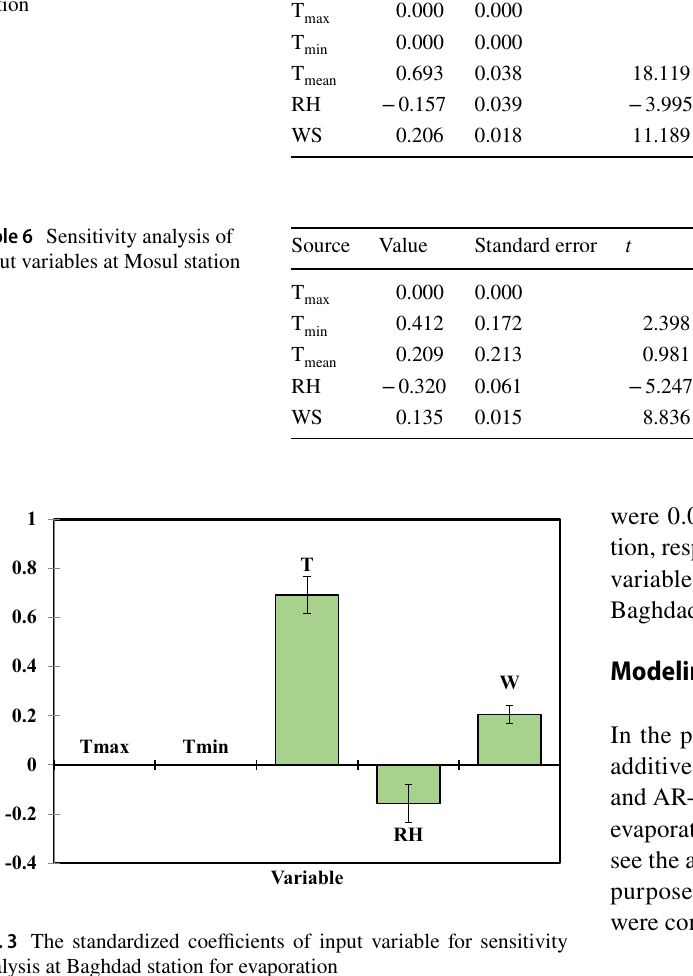
Table 5 Sensitivity analysis of input variables at Baghdad station